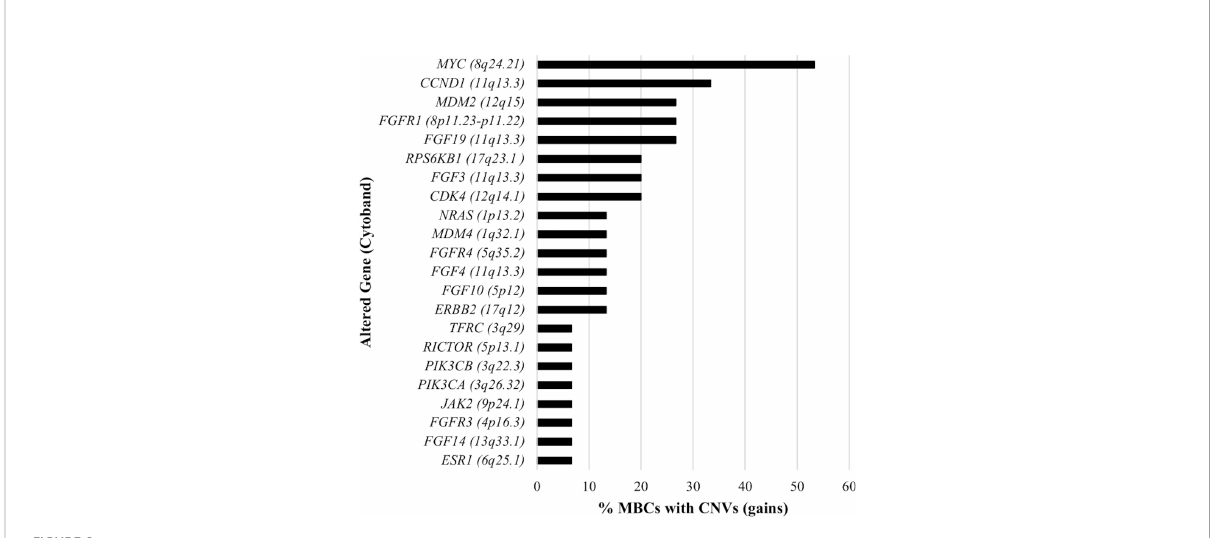
FIGURE 2 Percentage of MBCs with DNA Copy Number Variations (CNVs), by altered